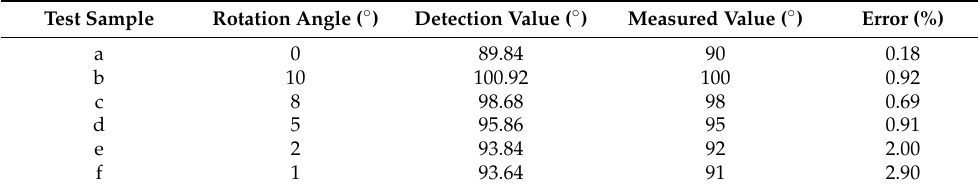
Figure 8. Identification results of loose bolts at tiny angle: ( a ) initial state; ( b ) 10° of rotation; ( c ) 8° of rotation; ( d ) 5° of rotation; ( e ) 2° of rotation; ( f ) 1° of rotation. Table 4. Experimental data analysis of bolt loosening at tiny angle.